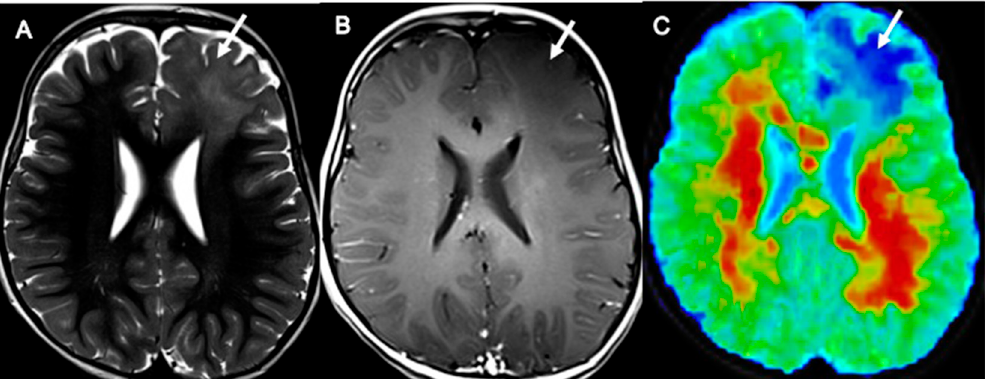
Figure 7. DKI values in pLGG. Axial TSE T2 sequences ( A ), T1 3D SPACE post-contrast sequences ( B ), and mean kurtosis color maps overlaid on T2 sequences ( C ) in a 4-year-old boy affected by a left frontal low-grade astrocytoma (grade 2 WHO). The pLGG (( A , B ), arrows) presents low MK values (( C ), arrows; MK of the tumor volume in this patient: 0.42). pLGG = pediatric low-grade glioma; MK = mean kurtosis.